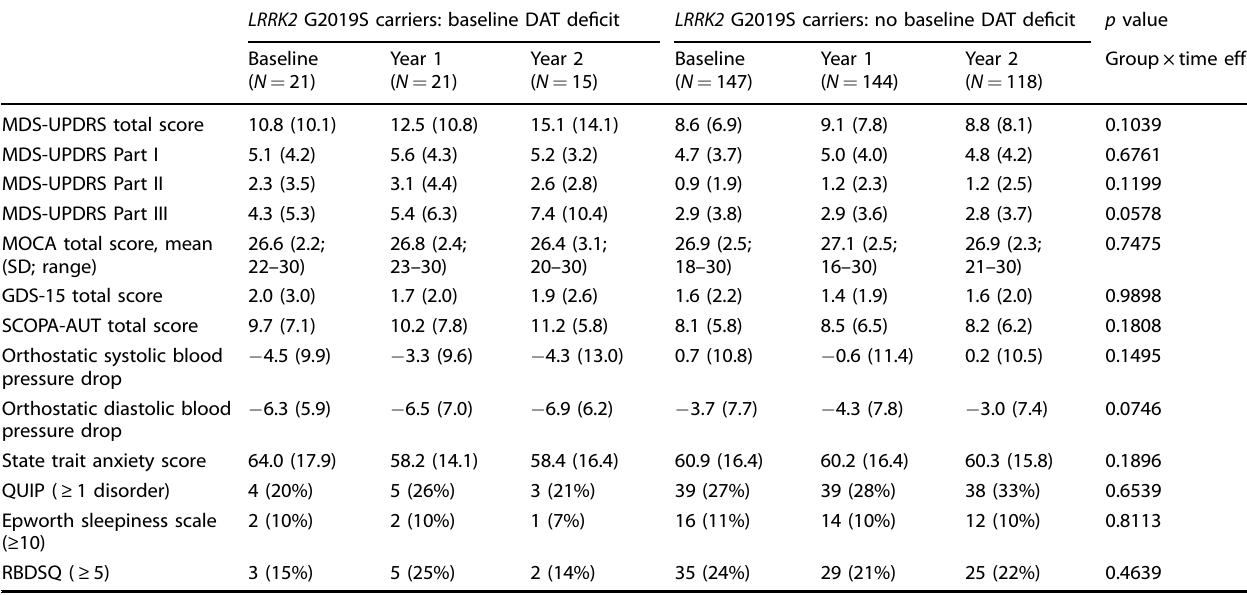
Table 3. Change in clinical characteristics among LRRK2 G2019S carriers with vs without baseline DAT de fi cit. LRRK2 G2019S carriers: baseline DAT de fi